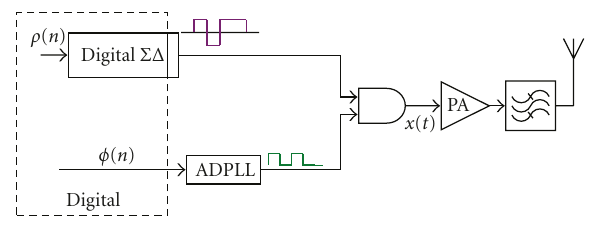
Figure 2: Architecture of a polar ΣΔ transmitter with RF recombi- nation [6].